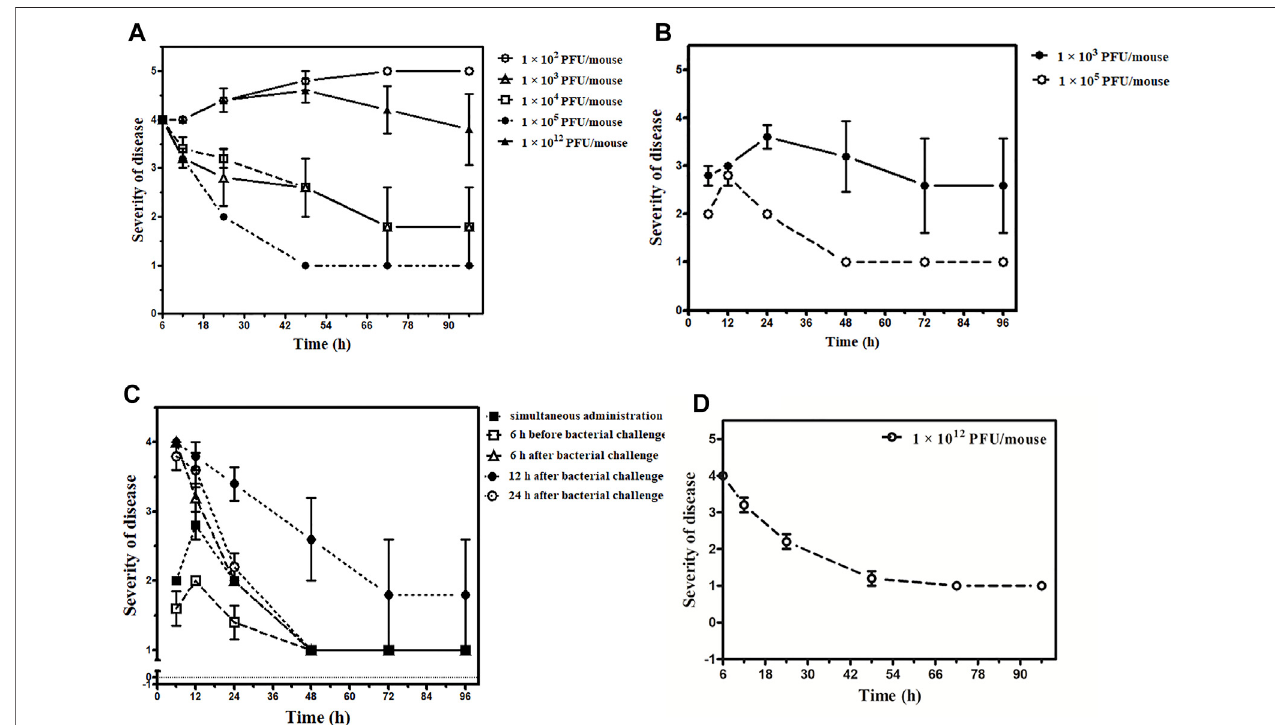
FIGURE5| Outcomeofthephagetherapyon Klebsiellapneumoniae septicemiaatdifferenttimepointsandphagedosage.The X -axisrepresentsthetimepointof assessment after administration of phage cocktail and Y -axis shows the grading of severity of disease ranging from 1- normal; 2- slight illness, lethargy, ruf fl ed fur; 3- moderateillness,severelethargy,ruf fl edfur,andhunchedback;4-asevereillnesswithaforementionedsigns,exudativeaccumulationaroundeyes;5-death. (A) Phage cocktail (1 × 10 2 , 1 × 10 3 , 1 × 10 4 , 1 × 10 5 , 1 × 10 12 PFU/mouse) given 6 h after bacterial challenge, 1 × 10 2 PFU/mouse denoted by an open circle ( ○ ), 1 × 10 3 PFU/mousedenotedbyanopentriangle( Δ ),1×10 4 PFU/mousedenotedbyanopensquare( □ ),1×10 5 PFU/mousedenotedbyanclosedcircle( mouse denoted by an closed triangle ( ▲ ). (B) Phage cocktail (1 × 10 3 , 1 × 10 5 PFU/mouse) given simultaneously, 1 × 10 3 PFU/mouse denoted by the closed circle ( and 1 × 10 5 PFU/mouse denoted by an open circle ( ○ ). (C) Phage cocktail (1 × 10 5 PFU/mouse) given simultaneously denoted by a closed square ( ■ ), 6 h before bacterialchallengedenotedbyopensquare( □ ),6 hafterbacterialchallengedenotedbyanopentriangle( Δ ),12 hafterbacterialchallengedenotedbyaclosedcircle( and24 hafterbacterialchallengedenotedbyanopencircle( ○ ).Thebacterialchallengedoseisconstantfortheentiregroupwith8×10 7 CFU/mouseconcentration. (D) Phage cocktail (1 × 10 12 PFU/mouse) given 24 h after bacterial challenge denoted by an open circle ( ○ ).